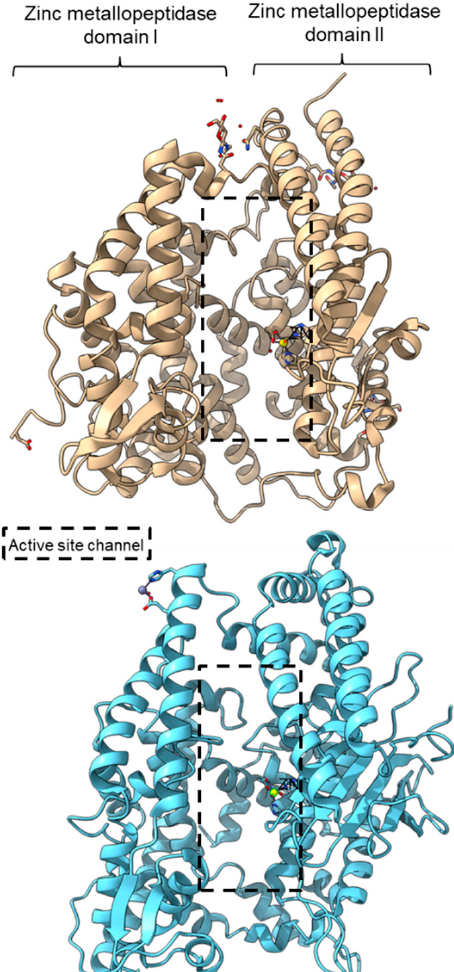
Figure 4. Crystal structures of the MEROPS metallopeptidase M02.006 angiotensin-converting enzyme-2, ACE2 (top, PDB ID: 1R42), and M03.002 neurolysin (bottom, PDB ID: 1I1I). Metallopeptidase M12 BmooMPalpha-I (M12.338, 3gbo) with a molecular mass of